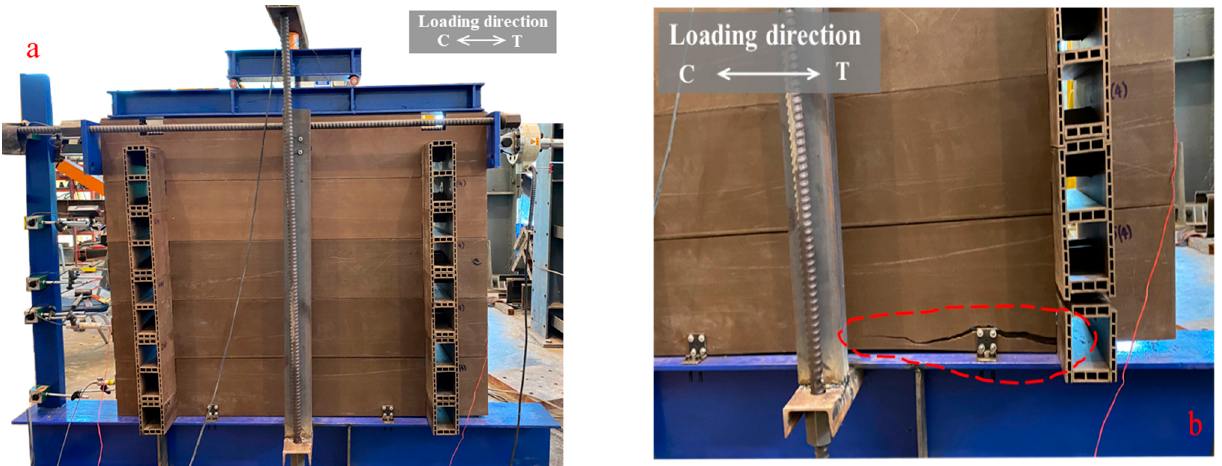
Figure 8. WPVC composite log-wall specimen (W01) under compressive loading: ( a ) Overall deformed shape; ( b ) Separation between first main log-member and support.